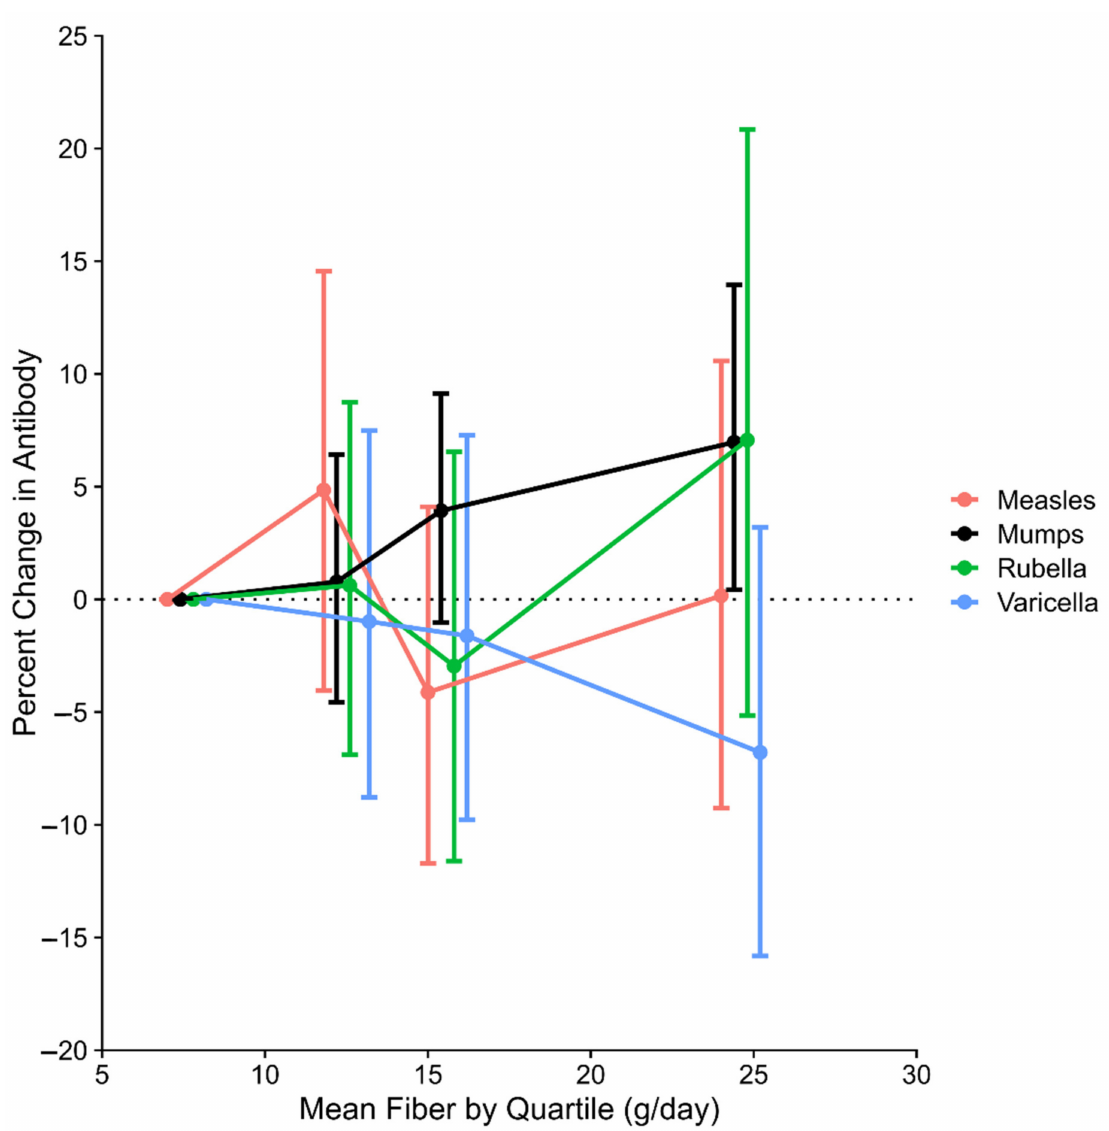
Figure 1. Fully-adjusted percentage change in antibody concentration (and 95% confidence interval) according to quartile of energy-adjusted fiber